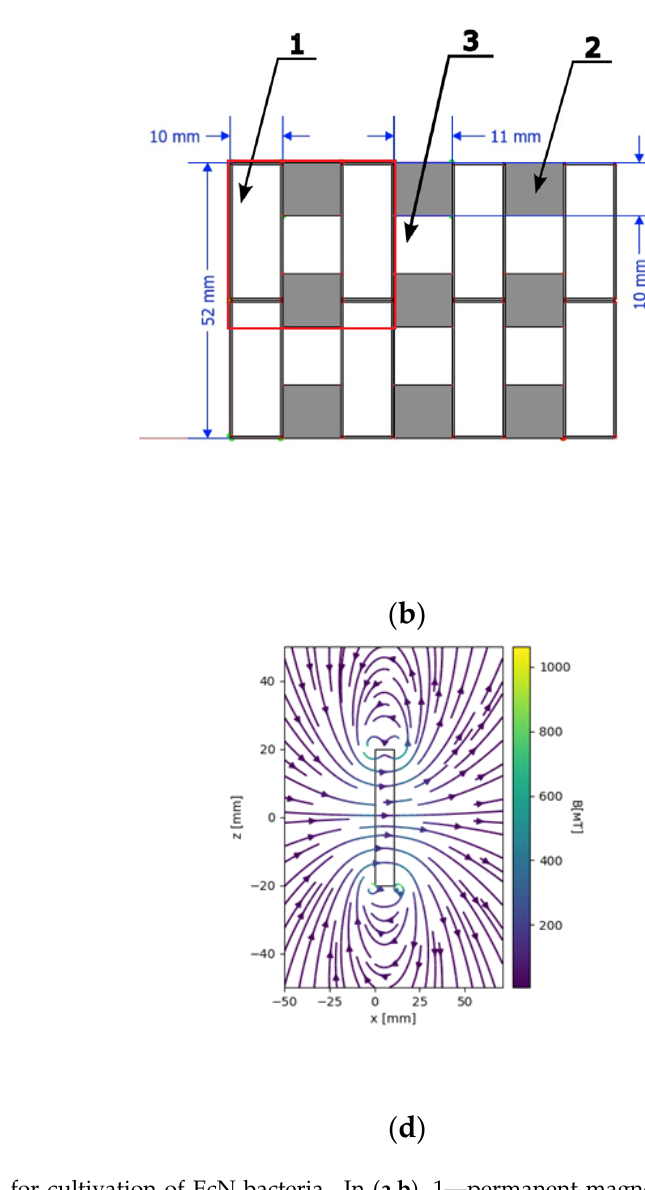
Figure 1. Magnetic system for cultivation of EcN bacteria. In ( a , b ), 1—permanent magnet, 2—magnetic circuit, and 3—working volume of the magnetic system for cultivation of the EcN. The magnetic field flux density was measured to be a maximum of 0.15 T inside the working volume of the magnetic system. The measurement was carried out by means of a Magnetic Field Flux Density Meter Ш 1-8 with Hall-type sensor. The size of the magnetic field sensor (Magnetic Field Flux Density Meter Ш 1-8) is 6 mm. Therefore, the specified sensor can measure the magnetic field flux density averaged on the scale of the characteristic dimensions of the sensor at the center of the working volume (3). The red frame shows the unit cell of the magnetic system used for calculation of both the magnetic field flux density distribution and the magnetic field gradient distribution in the working volume of the magnetic system. ( c , d ) Unit of the magnetic system and the spatial distribution of the MF within it. The magnetization of the magnets is directed along the x-axis. The magnetic field flux density at the central area is 150 mT.